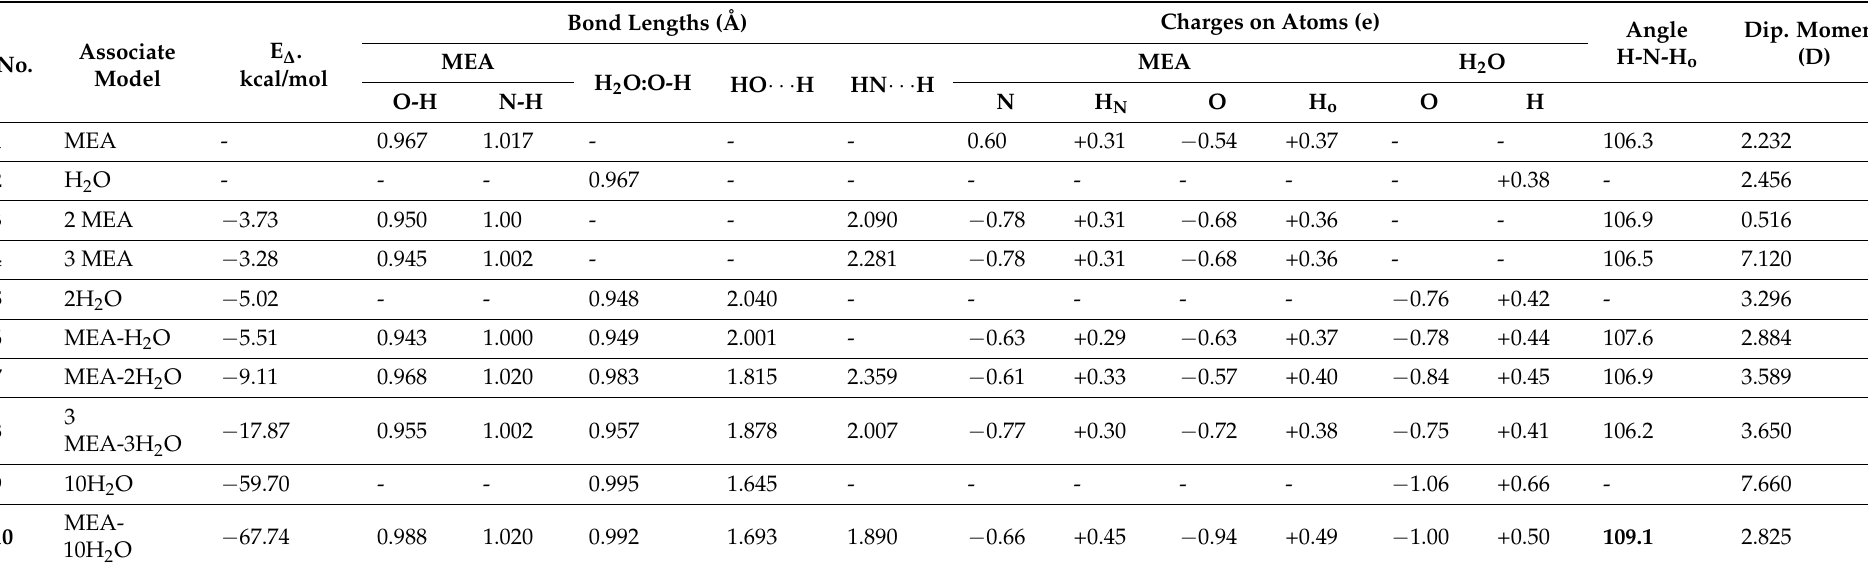
Table 2. Structural, electronic, and energy characteristics of models of various associates in comparison with the initial models of MEA and H 2 O. An analysis of data presented in Table 2 allows us to conclude that association energy, which determines the stability of a complex, depends significantly on the structure of the complex and, to a large extent, on the number of hydrogen bonds. As the strength of the associate increases, the polarizability of N-H and O-H atoms involved in association increases, i.e., positive charges on hydrogen atoms and negative charges on oxygen and nitrogen atoms involved in the association increase. Lengths of hydrogen bonds in the most stable complexes are shorter, while bonds between atoms inside the molecule are lengthened. From the data in Table 2, it is obvious that all listed changes in structural and electronic characteristics are more pronounced in the MEA-10H 2 O associate, as well as in the associate of 10 water molecules (last 2 rows of Table 2). Structures of these associates, together with the theoretical vibrational spectra, are shown in Figures 5 and 6. In these associates, oxygen atoms arise in water molecules with a negative charge equal to − 1, and the total charge of two protons at such oxygen atoms is equal to